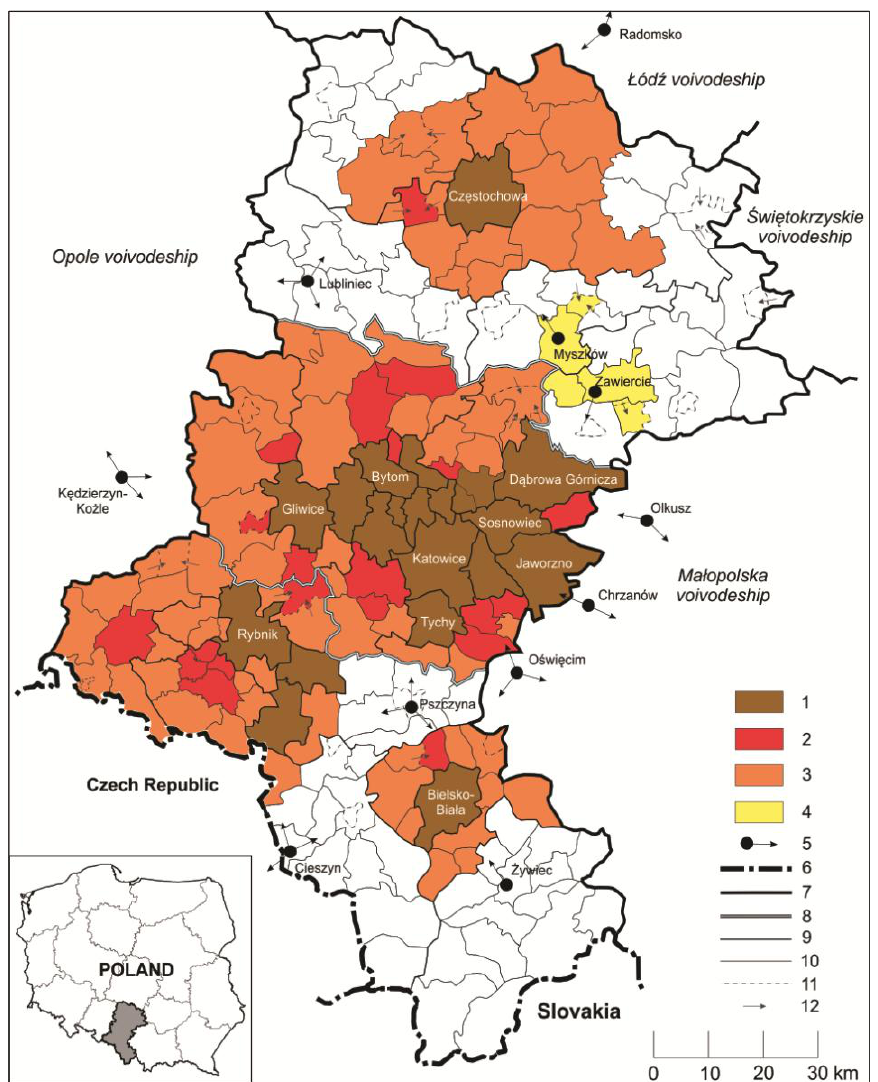
Fig. 1. Urban agglomerations of the Silesian voivodeship. Spatial-administrative structure (by Krzysztofik, 2008) 1 - core of agglomeration or conurbation; 2 - inner-zone of agglomeration or conurbation; 3 - outer-zone of agglomeration or conurbation; 4 - other agglomerated unit; 5 - subregional town and directions of gravitation to the nearest agglomerations; 6 - boundary of Poland; 7 - voivodeship boundaries; 8 - Katowice conurbation boundaries; 9 - district boundaries; 10 - community boundaries; 11 - boundary between the rural and urban area of the urban-and-rural community; 12 - membership of the rural area to the urban-and-rural